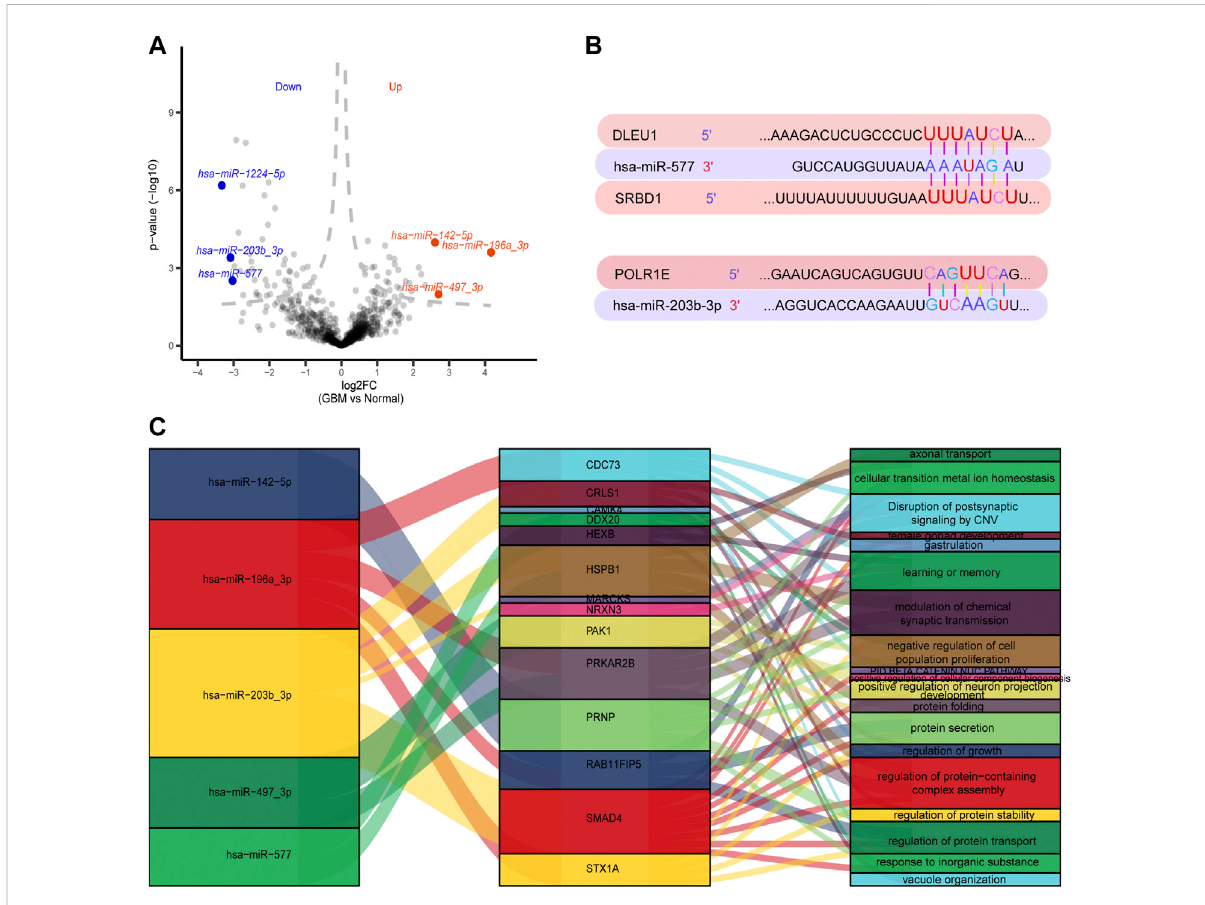
FIGURE 6 Regulation between 91 prognosis-related genes and the top three differentially expressed miRNAs (DEmiRs) with the largest |log 2 (fold change)|. (A) Volcano plots of DEmiRs in GSE25631. Red dots indicate the top three up-regulated DEmiRs and blue dots indicate top three down- regulated DEmiRs. (B) Binding sites of top three DEmiRs with the largest |log 2 (fold change)| and prognosis-related genes. (C) A Sankey diagram was generated using three DEmiRs with the largest |log 2 (fold change)|, prognosis-related genes and